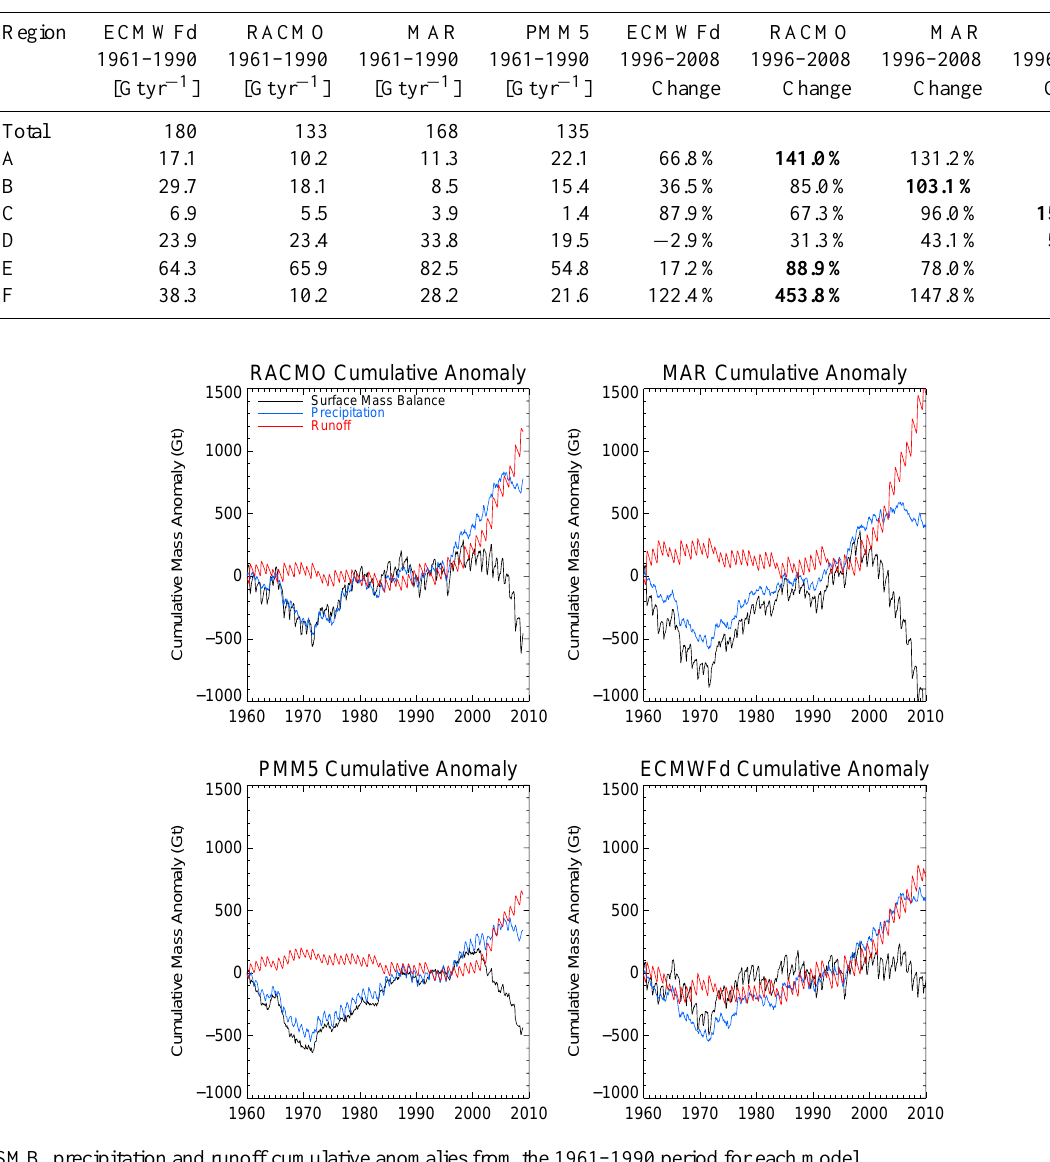
Table 4. Annual regional runoff (common mask); the mean over 1961–1990 period and the change over 1996–2008 period. Largest change highlighted in bold.